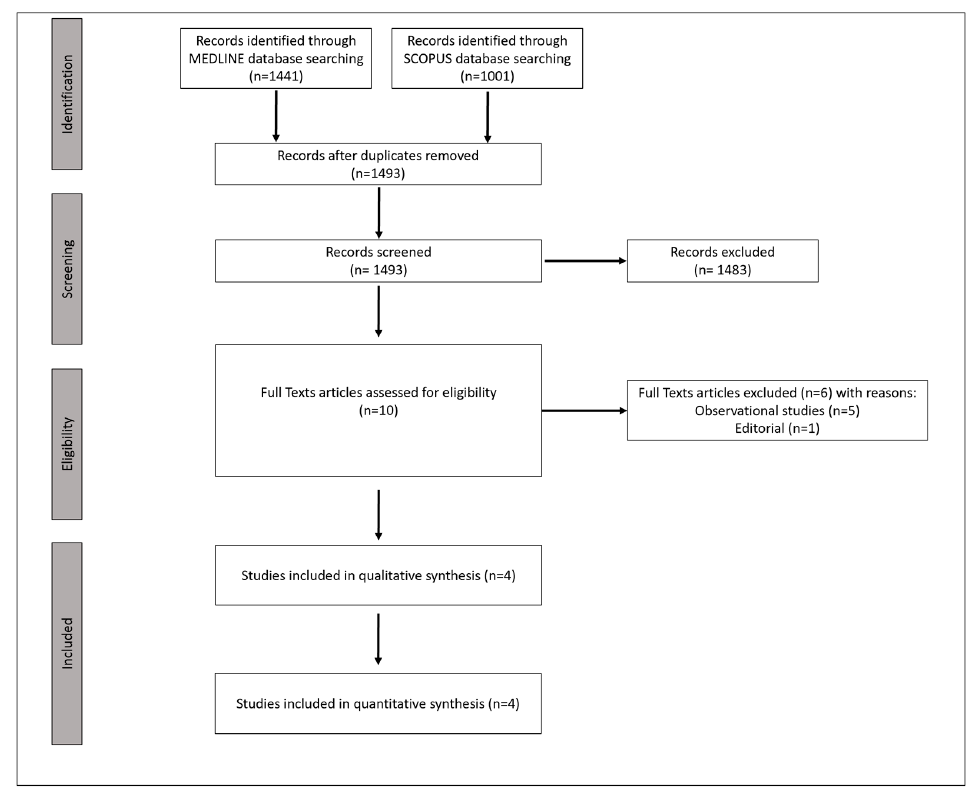
Figure 1. Flow chart of the systematic review.